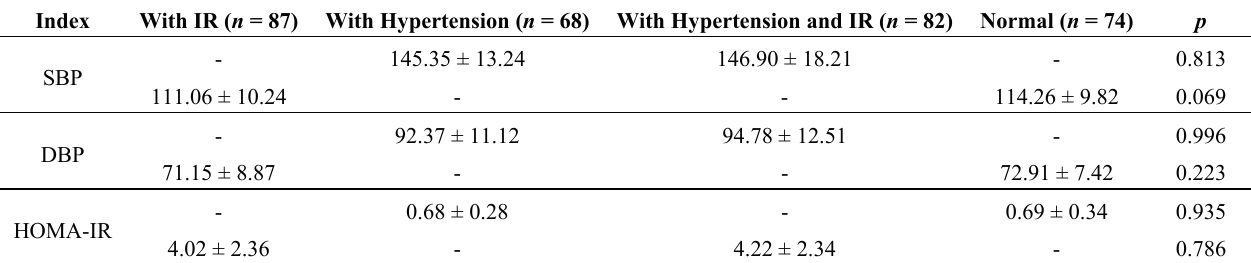
Table 1. Balancing tests for SBP, DBP and HOMA-IR among the four groups.